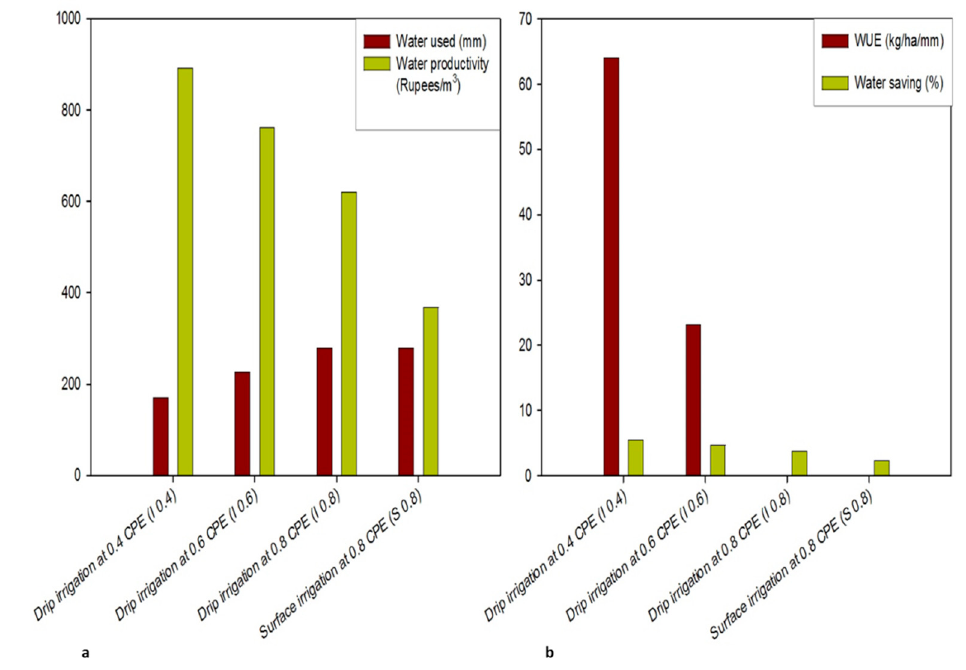
Figure 2. Effect of drip irrigation levels on water use, water productivity, water-use efficiency, and water saving (pooled data of three years). ( a ): water used and water productivity; ( b ): Water use efficiency and water saving.